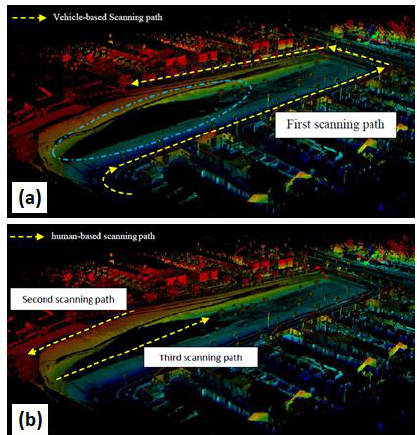
Figure 8. Mobile laser scanning data of the study area - (a) point cloud data acquired using vehicle-based mode; (b) point cloud data acquired using human-based mode